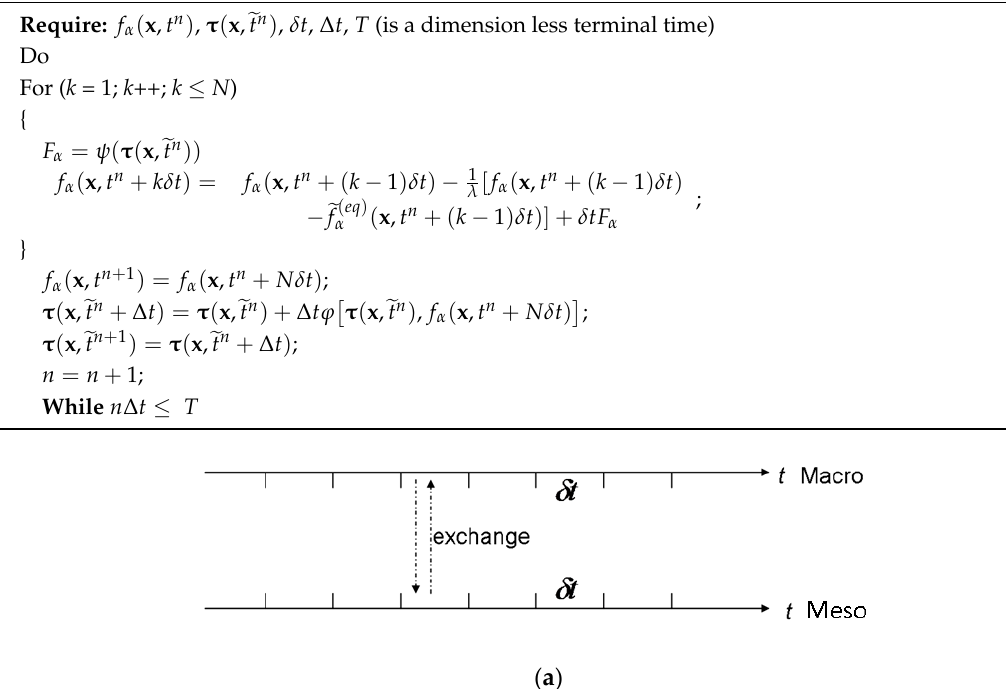
Algorithm 2. Generalized asynchronously coupling method.